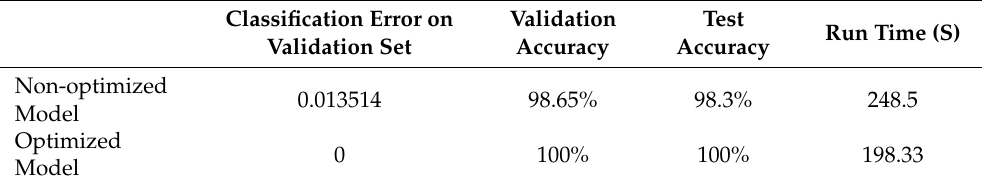
Table 3. Comparison results of the proposed Bayesian-based optimal model with a non-optimized version of the proposed CNN.